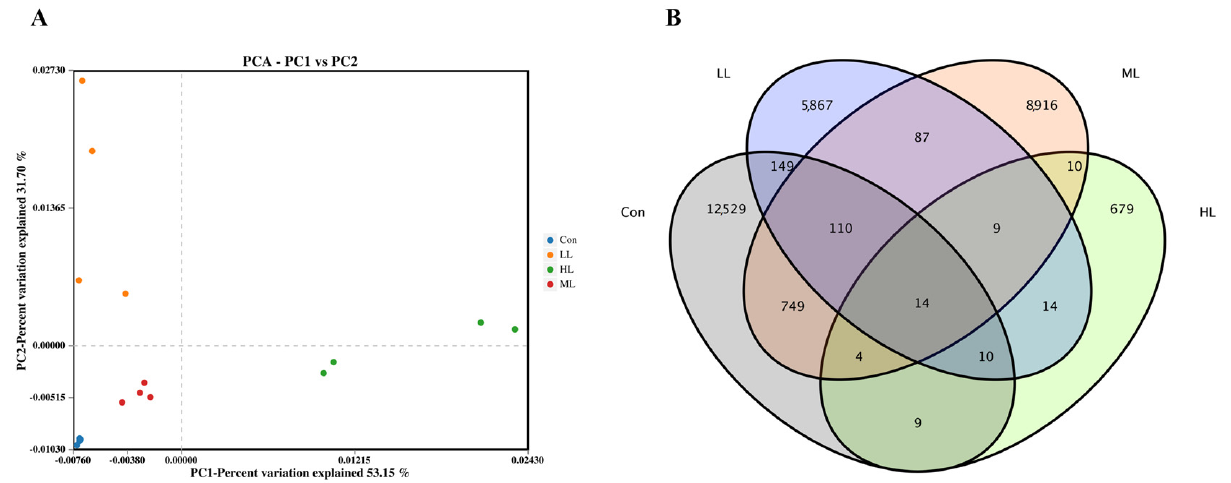
Figure 4. The principal component analysis and Venn diagram of intestinal microbiota of largemouth bass. ( A ) The principal component analysis. ( B ) The Venn diagram. Con means control diet. LL, ML, and HL mean 5 g Kg − 1 , 10 g Kg − 1 and 15 g Kg − 1 laminarin was supplemented into diets, respectively.